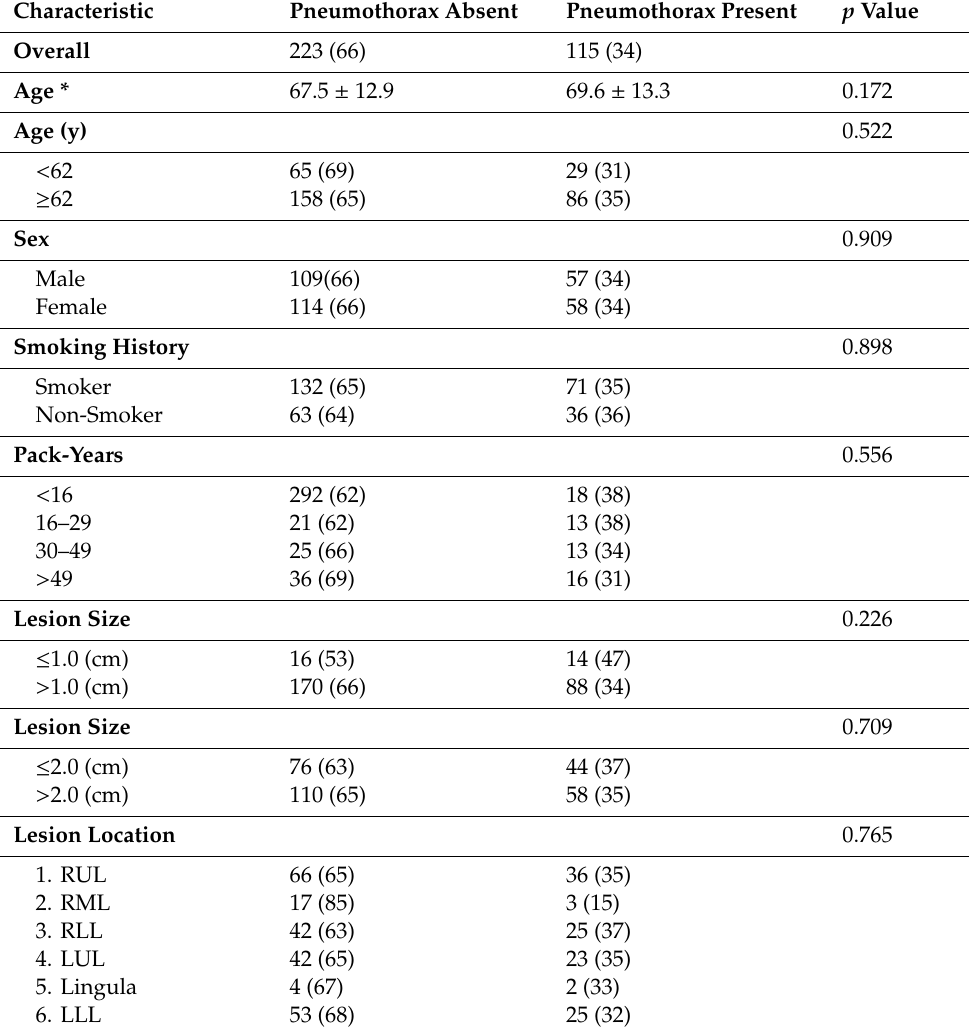
Table 1. Risk factors of pneumothorax after computed tomography (CT)-guided lung biopsy. Characteristic Pneumothorax Absent Pneumothorax Present p